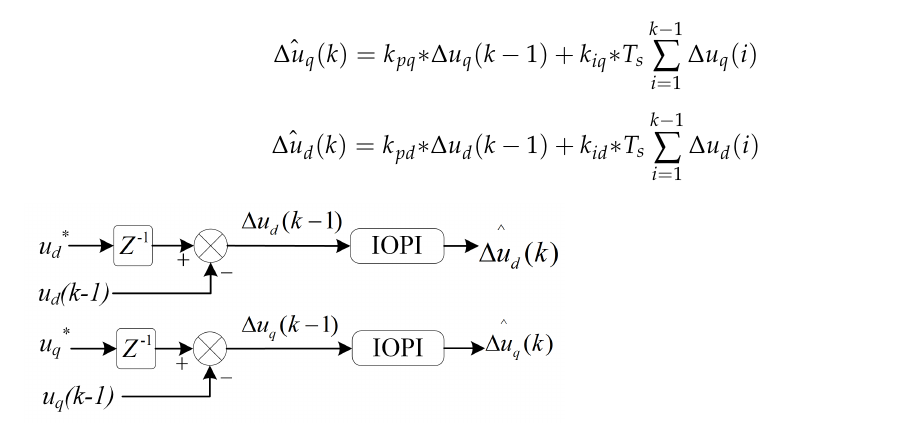
Figure 6. IOPI error voltage